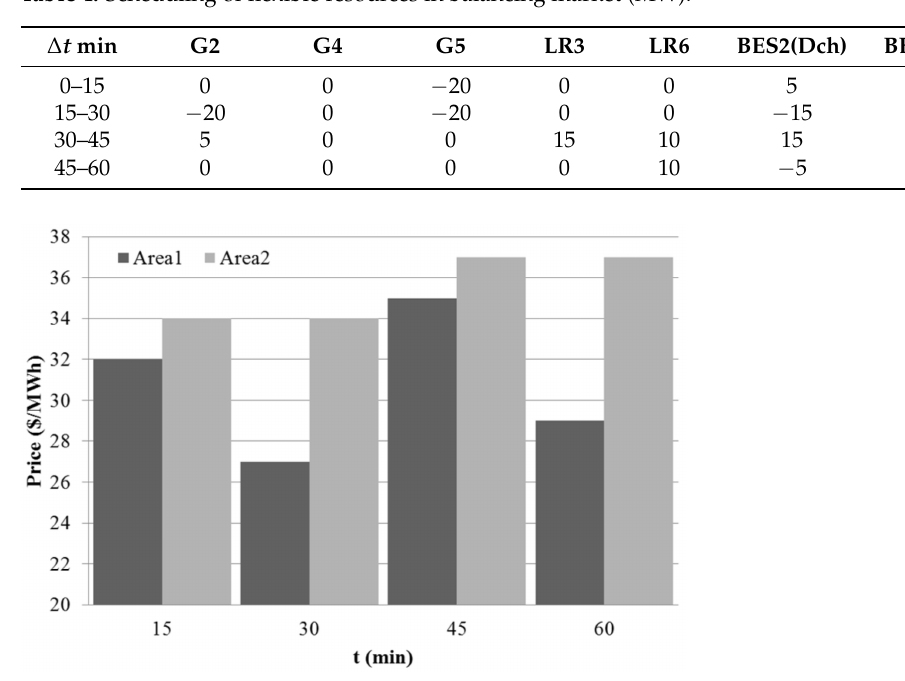
Table 4. Scheduling of flexible resources in balancing market (MW).